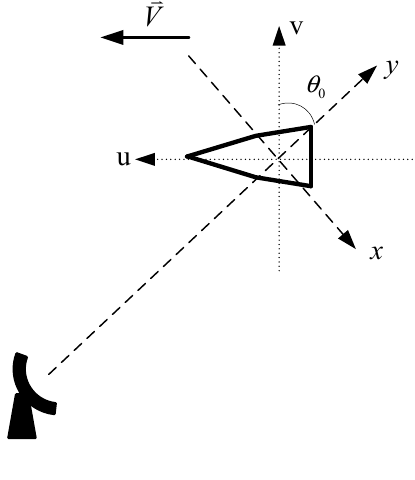
Figure 3. Moving scene of the